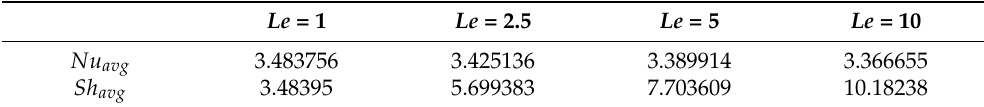
Table 7. Average Nu and Sh